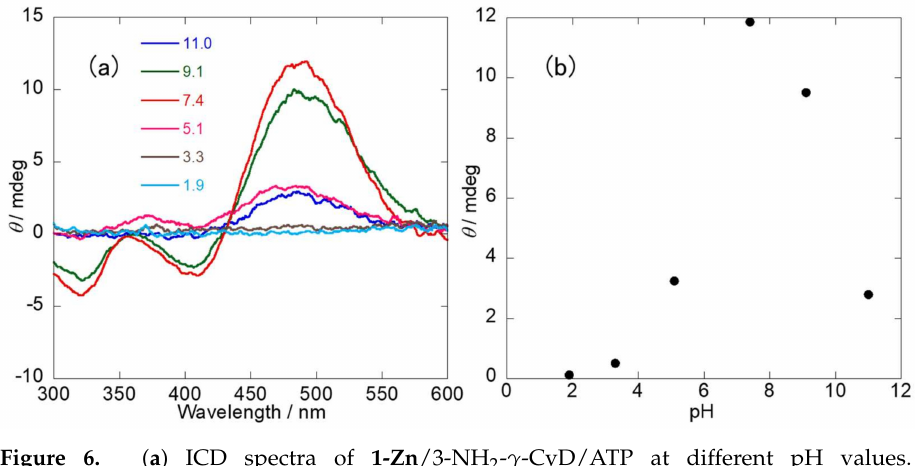
Figure 6. ( a ) ICD spectra of 1-Zn /3-NH 2 - γ -CyD/ATP at different pH values. ( b ) Plot of θ 490 —of 1-Zn /3-NH 2 - γ -CyD /ATP versus pH. [ 1-Zn ] = 0.040 mM, [ATP] = 4.0 mM, [3-NH 2 - γ -CyD] = 4.0 mM, in 2% DMSO